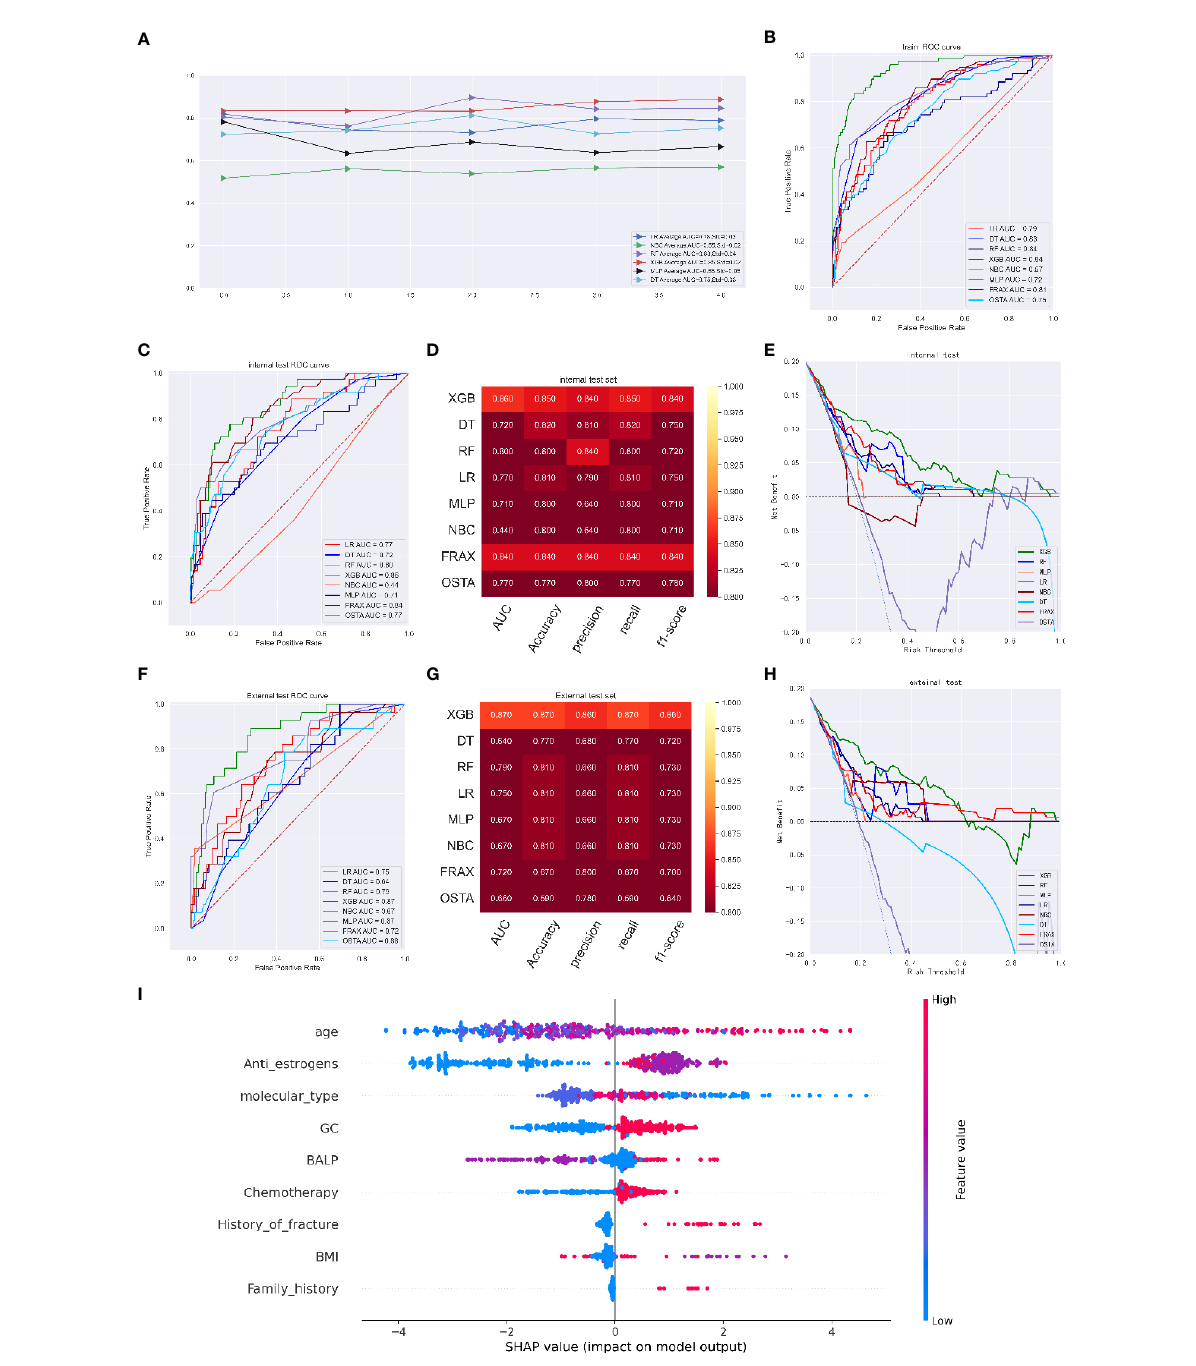
FIGURE 2 (A) Five-fold cross-validation results of different machine models in training set. Abbreviations: DT: Decision tree; LR: Logistic regression; MLP: Multilayer Pecepreon; NBC: Naive Bayes classi fi cation; RF: Random Forest; XGB: eXtreme gradient boosting. (B) The ROC curve of different machine learning models,FRAX score and OSTA score in training test set. (C) The ROC curve of different machine learning models, FRAX score and OSTA score in internal test set. (D) Prediction performance of different models, FRAX score and OSTA score in internal test set. (E) The DCA curve of different machine learning models, FRAX score and OSTA score in internal test set. (F) The ROC curve of different machine learning models, FRAX score and OSTA score in external test set. (G) Prediction performance of different models, FRAX score and OSTA score in external test set. (H) The DCA curve of different machine learning models, FRAX score and OSTA score in external test set. (I) Summary plots for SHAP values. For each feature, one point corresponds to a single patient. A point ’ s position along the x axis (i.e., the actual SHAP value) represents the impact that feature had on the model ’ s output for that speci fi c patient. (osteoporosis predicting